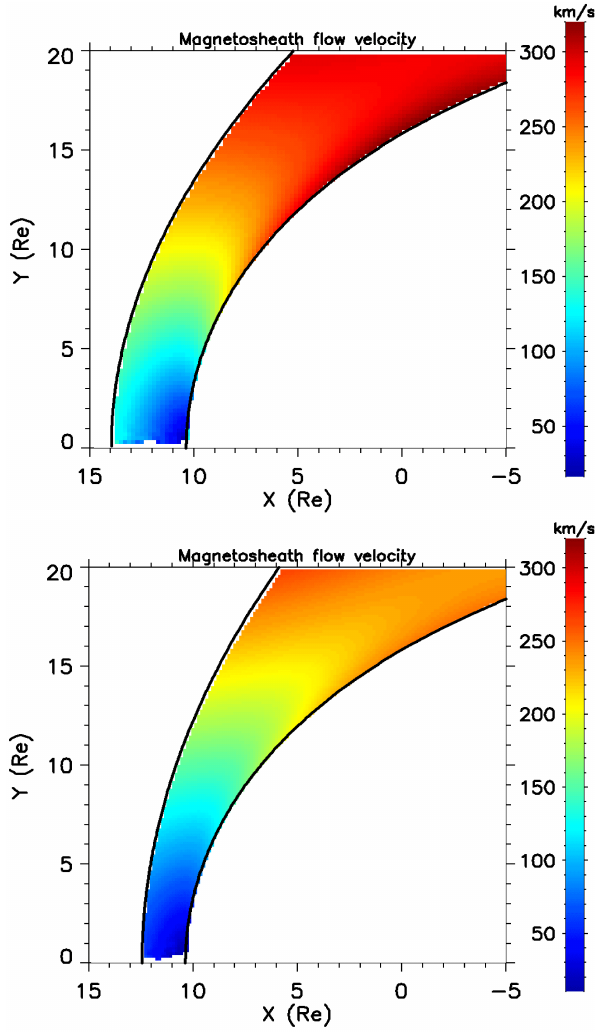
Fig. 2. Colour maps of the magnetosheath velocity (kms − 1 ) calcu- lated using the Soucek and Escoubet (2012) model – upper panel: Farris et al. (1991) bow shock model – lower panel: Jeˇráb et al. (2005) bow shock